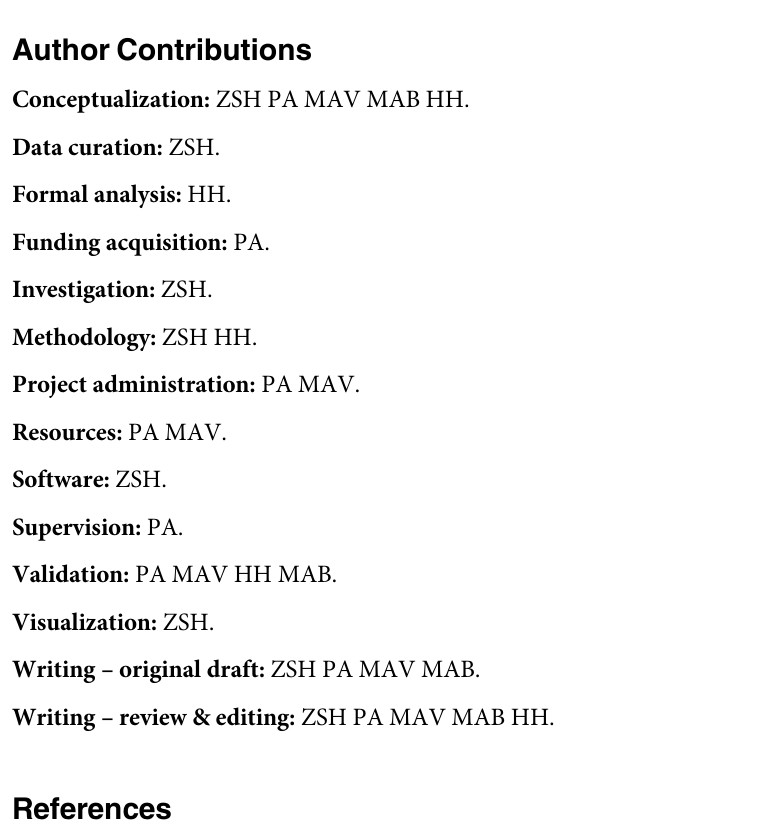
S2 Fig. Moderator effects of coping styles on the relationship between acceptance and com- mitment therapy and self-care